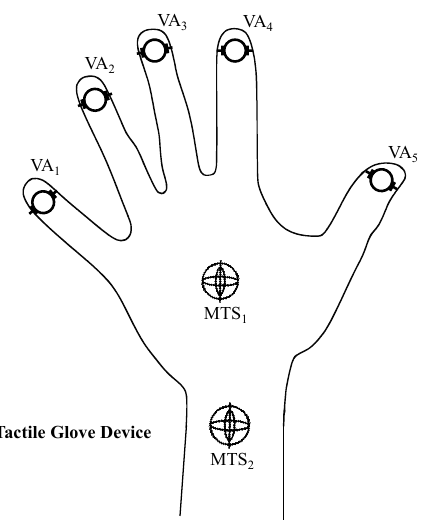
Figure 4. Position of sensors’ motion tracking sensors (MTSs) and actuators’ vibration actuators (VAs) in tactile glove.